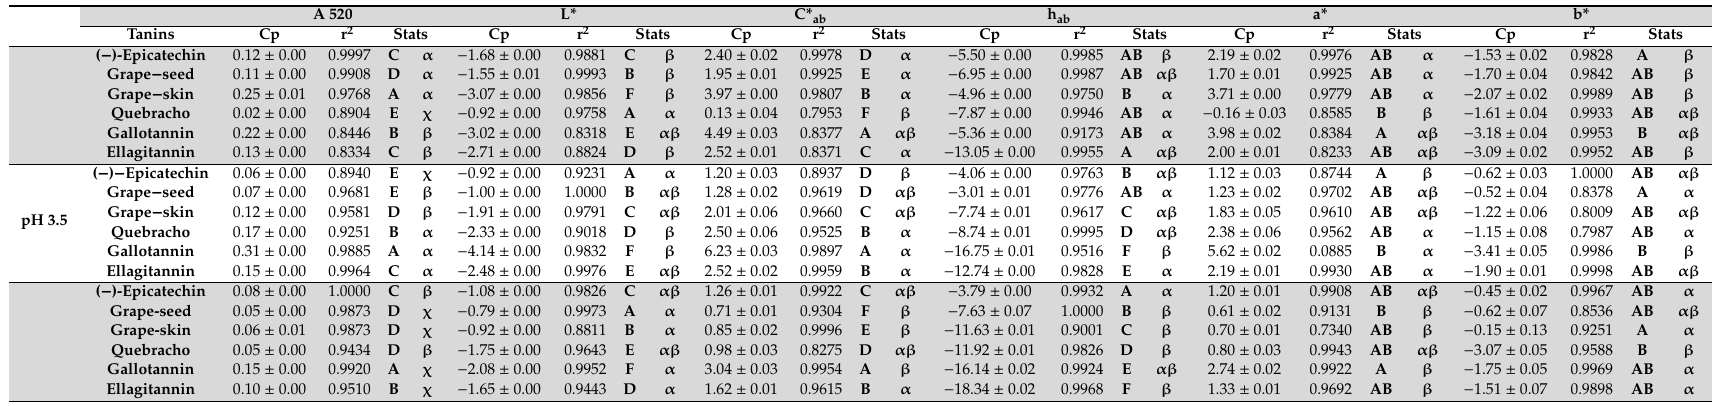
All data are the mean ± SD of three replicates. Stats: Statistic. Di ff erent capital caster letters indicate the existence of significant di ff erences between tannins for the same pH level ( p < 0.05). Di ff erent Greek letters indicates the existence of significant di ff erences between pH level for the same tannin ( p <